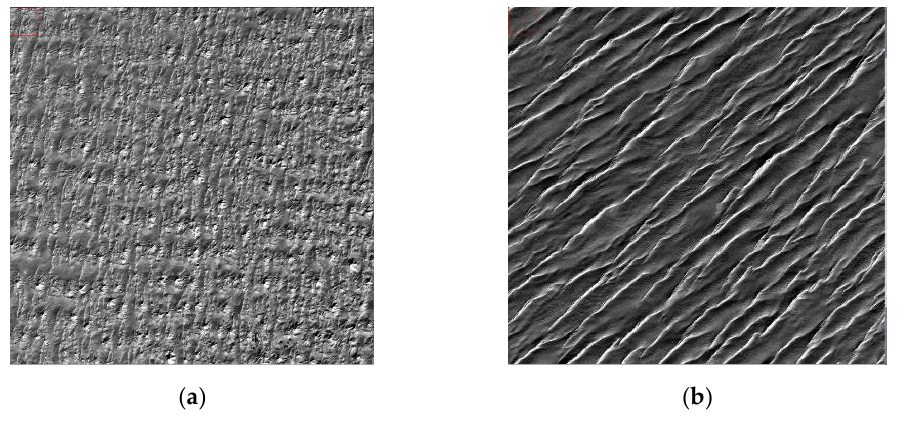
Figure 6. ( a ) Desert site Algeria 3; ( b ) desert site Arabia 1.